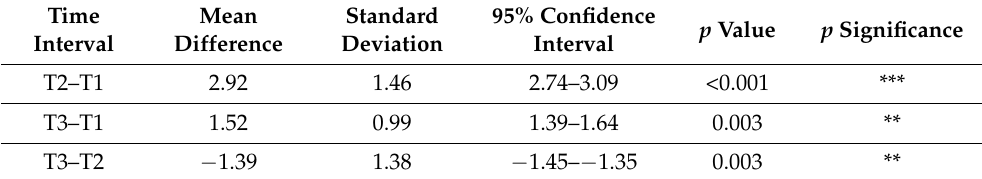
Table 3. Results of the mean differences (mm) of Nasal Width 6 in the three time intervals.